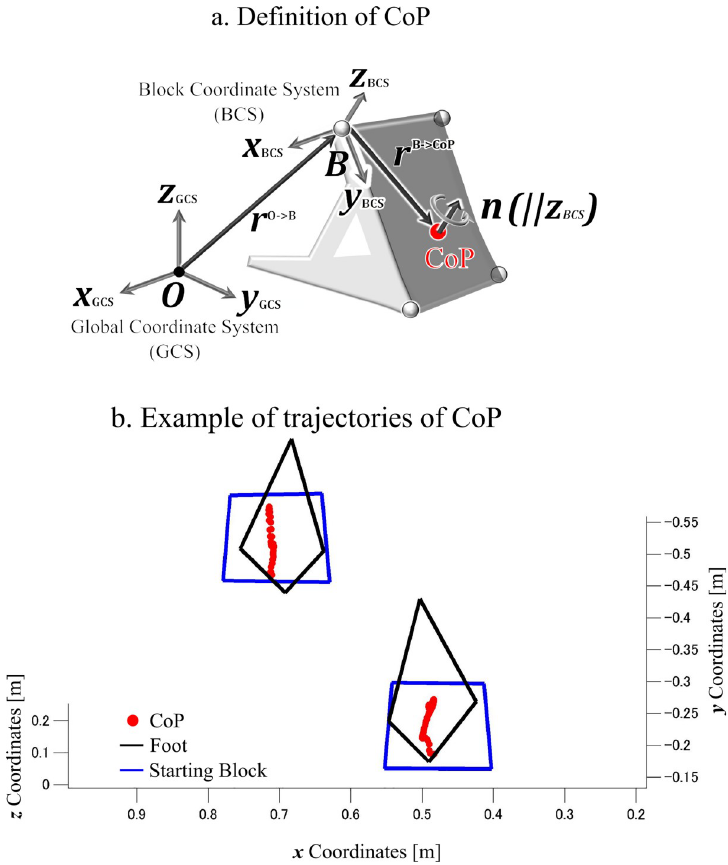
Fig 2. Calculation of the centre of pressure (CoP) (a), and a representative example of CoP trajectories (b).